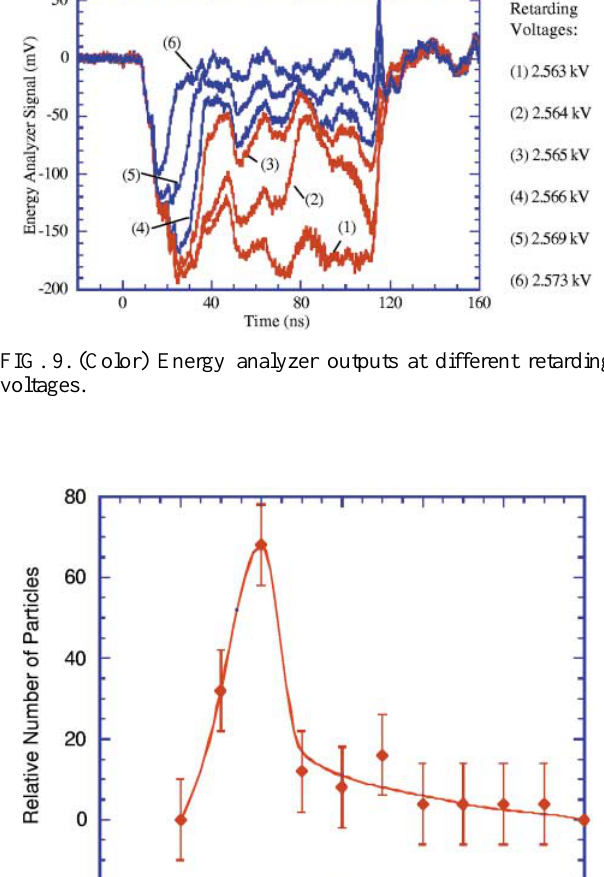
collective instabilities may produce relaxation towards